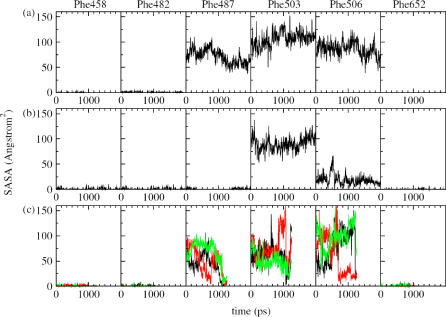
Solvent-Accessible Surface Area for a Number of Key Hydrophobic Residues in Equilibrium and TMD SimulationsThe Lee-Richards–type SASA [77] for Phe458, Phe482, Phe487, Phe503, Phe506, and Phe652 in the equilibrium simulations 1FMW (A) and 1VOM (B), and in the three TMD simulations (C) where different colors represent three different TMD trajectories. A water probe with radius 1.4 Å and the Nina-Roux set of atomic radii [74,75] are used. The GBSW model is used in both equilibrium and TMD simulations.